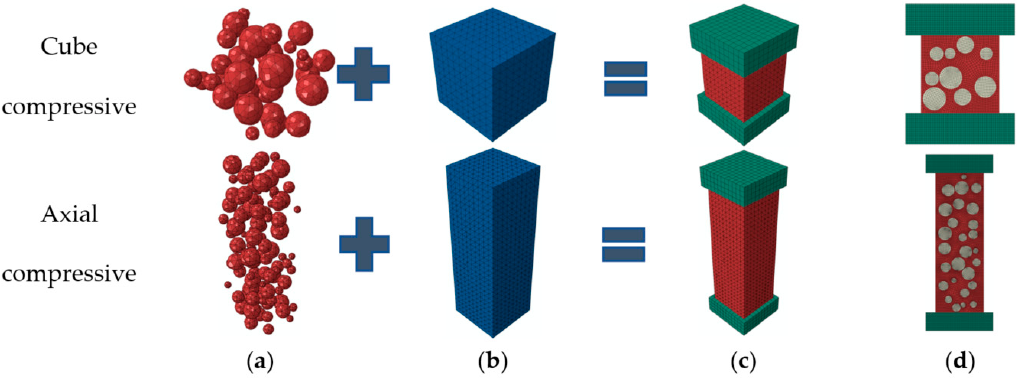
Figure 13. Random aggregate model of concrete: ( a ) aggregate, ( b ) mortar, ( c ) 3D model, and ( d ) 2D model.